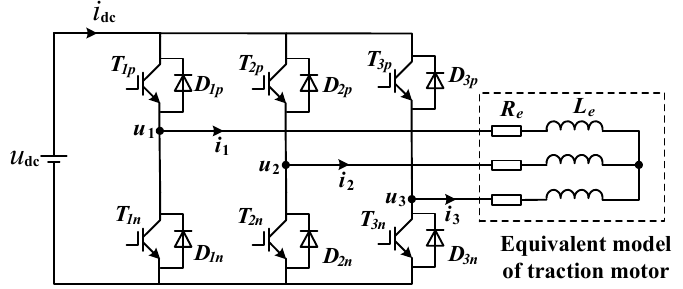
Figure 3. Equivalent model of the two-level traction inverter system.